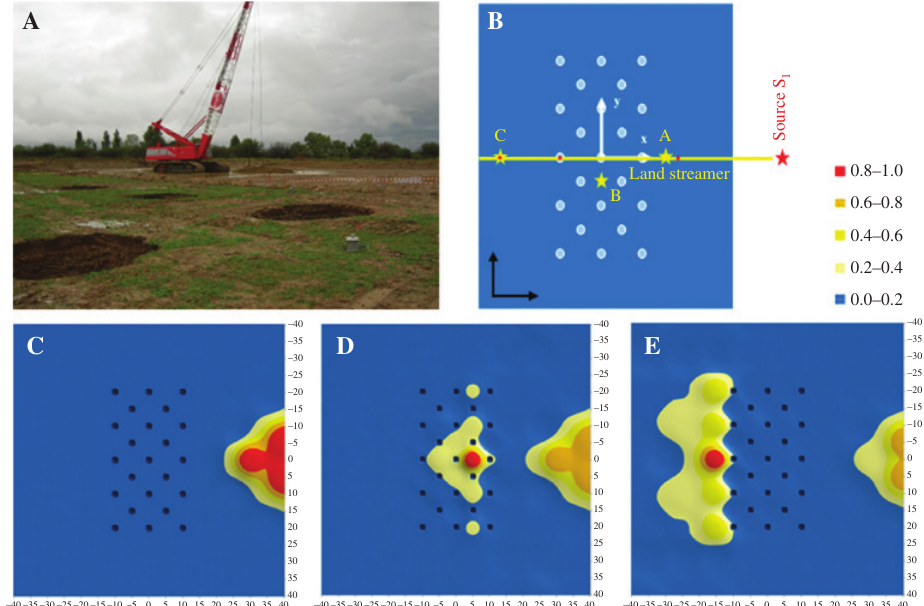
Figure 1: Experiment on a flat seismic lens: (A) Photo (courtesy of S. Brûlé) of the array of boreholes, (B), (C–E) Chronology of the x–y spatial distribution of normalized v 2 ( t ) from (C) 1.900 s to (D) 2.124 s to (E) 2.345